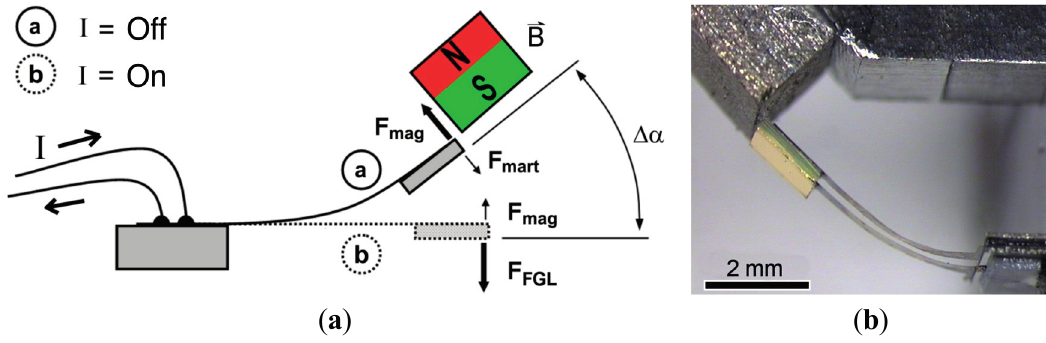
Figure 12. ( a ) Operation principle of the MSMA microactuator. Legend: N,S—north and south pole of a permanent magnet, F mag —magnetic force, F SMA —shape recovery force, F mart —force in martensitic state, Δα —deflection angle. ( b ) Photo of the MSMA microactuator. The lateral size of the double-beam cantilever is 3 × 0.4 mm 2 . Reprinted with permission from [65], copyright 2006 IOS Press.